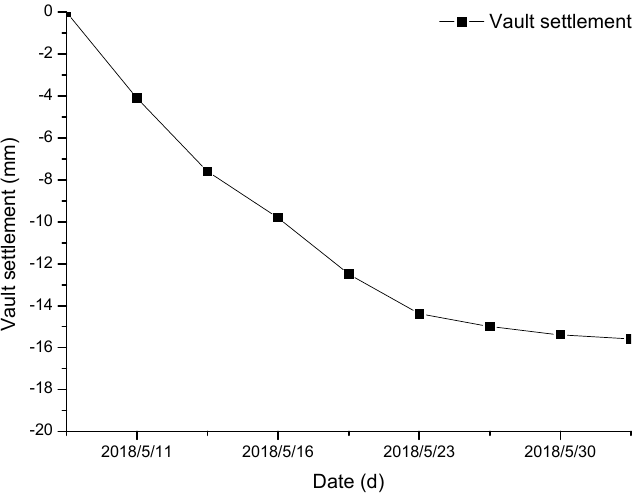
Figure 8. Settlement time history curve of arch crown.